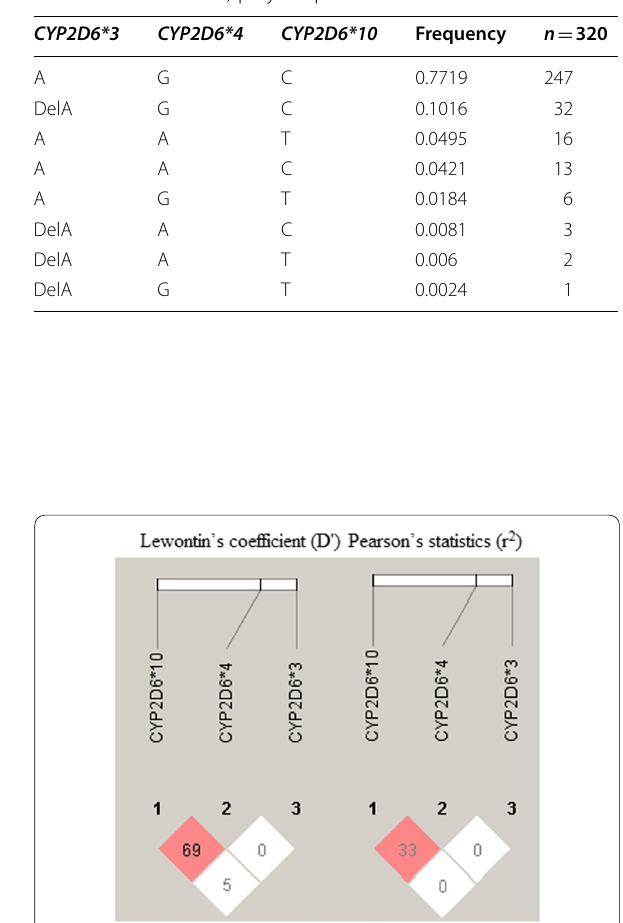
Fig. 2 Haploview figure showing Linkage disequilibrium (LD) plots characterizing haplotype blocks in CYP2D6 gene polymorphisms, in terms of Lewontin’s coefficient ( D ʹ ) and Pearson’s ( r 2 )